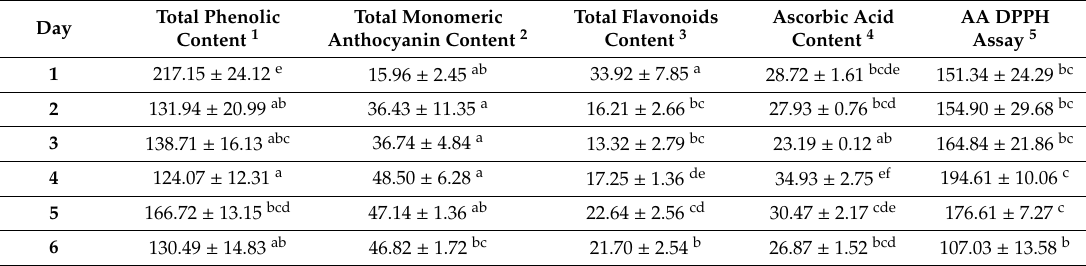
4 Results are expressed as mg of ascorbic acid / 100 g of fresh weight; 5 Results are expressed as mg of ascorbic acid / 100 g of fresh weight. Table 2. Fruits stored at 1 ◦ C in fridge, packaged in Nanoactive A film. E ff ect of storage period, on the total phenolic content, total monomeric anthocyanin content, total flavonoid content, the ascorbic acid content, and the antioxidant activity DPPH parameters in red raspberries (cv. Erika). The results are the mean of three replicates ± Standard Deviation. ** ( P ≤ 0.01); *** ( P ≤ 0.001). The letters represent the significant di ff erence vertically at P ≤